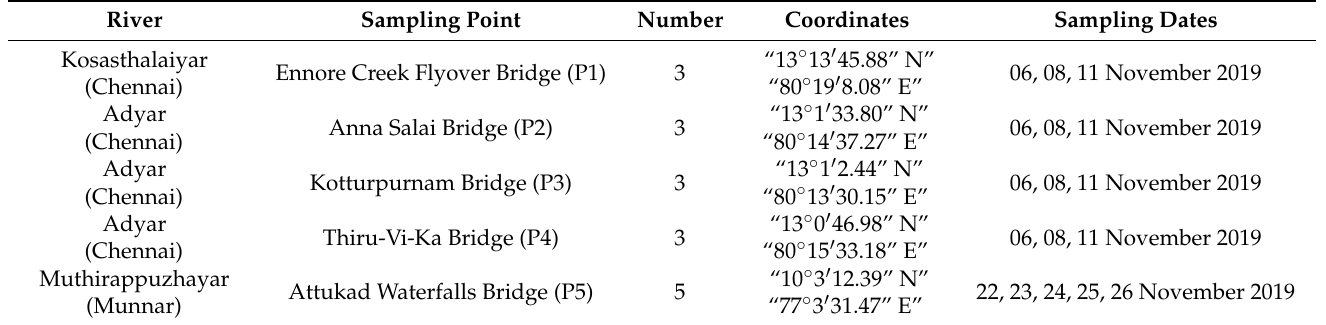
Figure 2. Sampling sites: P1—Ennore Creek Flyover Bridge (Chennai), P2—Anna Salai Bridge (Chennai), P3—Kotturpurnam Bridge (Chennai), P4—Thiru-Vi-Ka Bridge (Chennai), P5—Attukad Waterfalls Bridge (Munnar). Table 1. Sampling parameters of the five sampling sites.